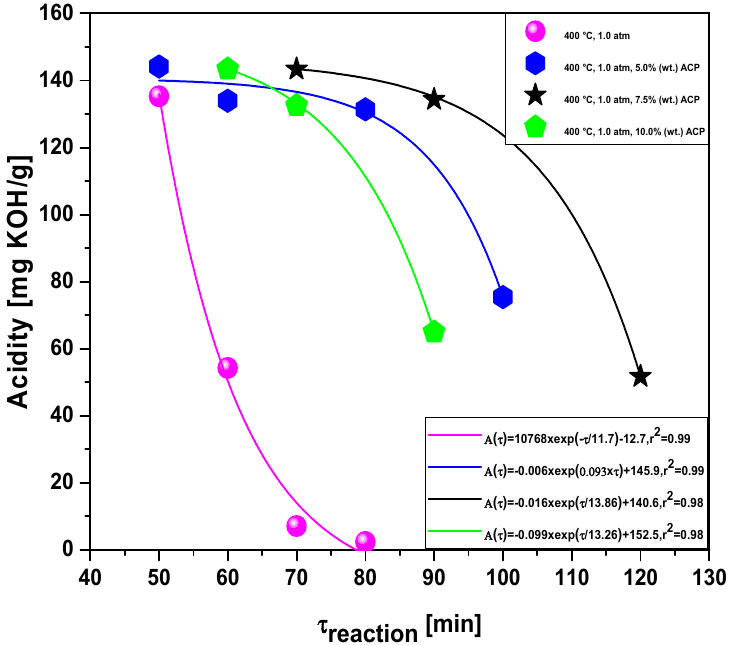
Figure 16. Effect of reaction time on the acidity of bio-oil by the upgrading of residual fat pyrolysis vapors at 400 °C, 1.0 atmosphere, 0.0%, 5.0%, 7.5%, and 10.0% (wt.) of activated carbon pellets impregnated with 10.0 M NaOH, using a catalyst fixed-bed reactor, using a semi-pilot scale two-stage reactor of 2.0 L.